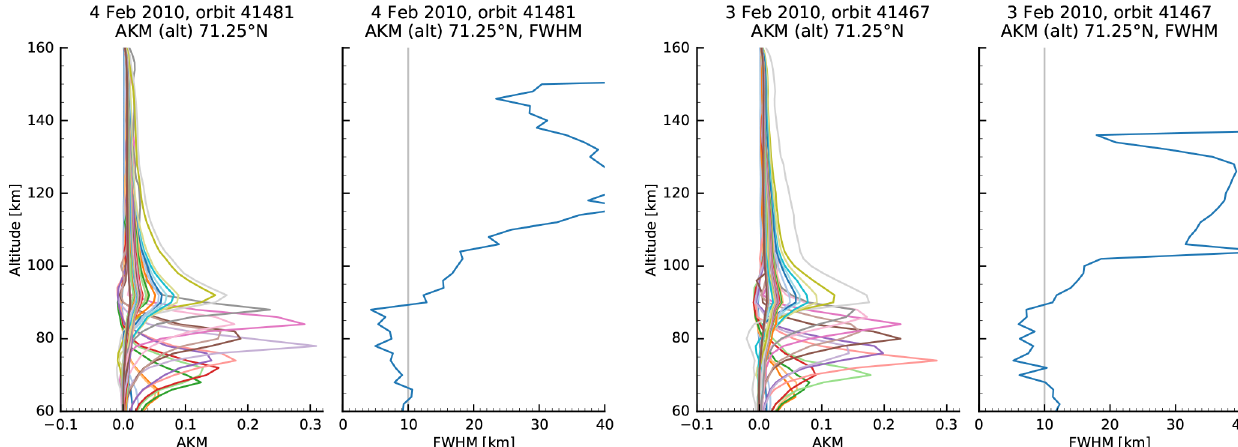
Figure 9. Altitude averaging kernel matrix elements (first panel from the left) and the respective full widths at half maximum (second panel) at the 71.25 ◦ N latitude bin for the sample nominal mode orbit (no. 41481, 4 February 2010). For comparison, the averaging kernel matrix elements from the retrieval of the MLT scan limited to below 91km and the full width at half maximum resolution at the same latitude bin of the sample MLT orbit are shown in the right two panels (sample orbit no. 41467, 3 February 2010).